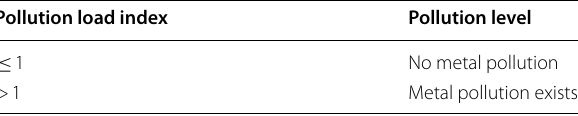
Tomlinson et al. (1980), Bramha et al. (2014)